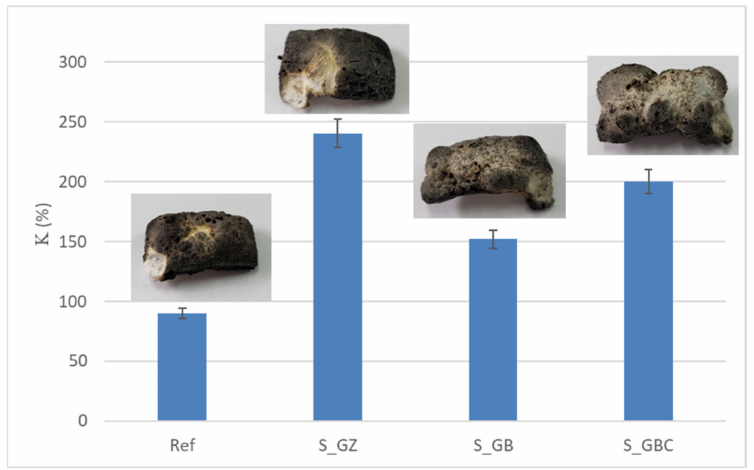
Figure 3. Visual aspect and intumescence coefficient (K) after 2 min of direct contact with the flame.